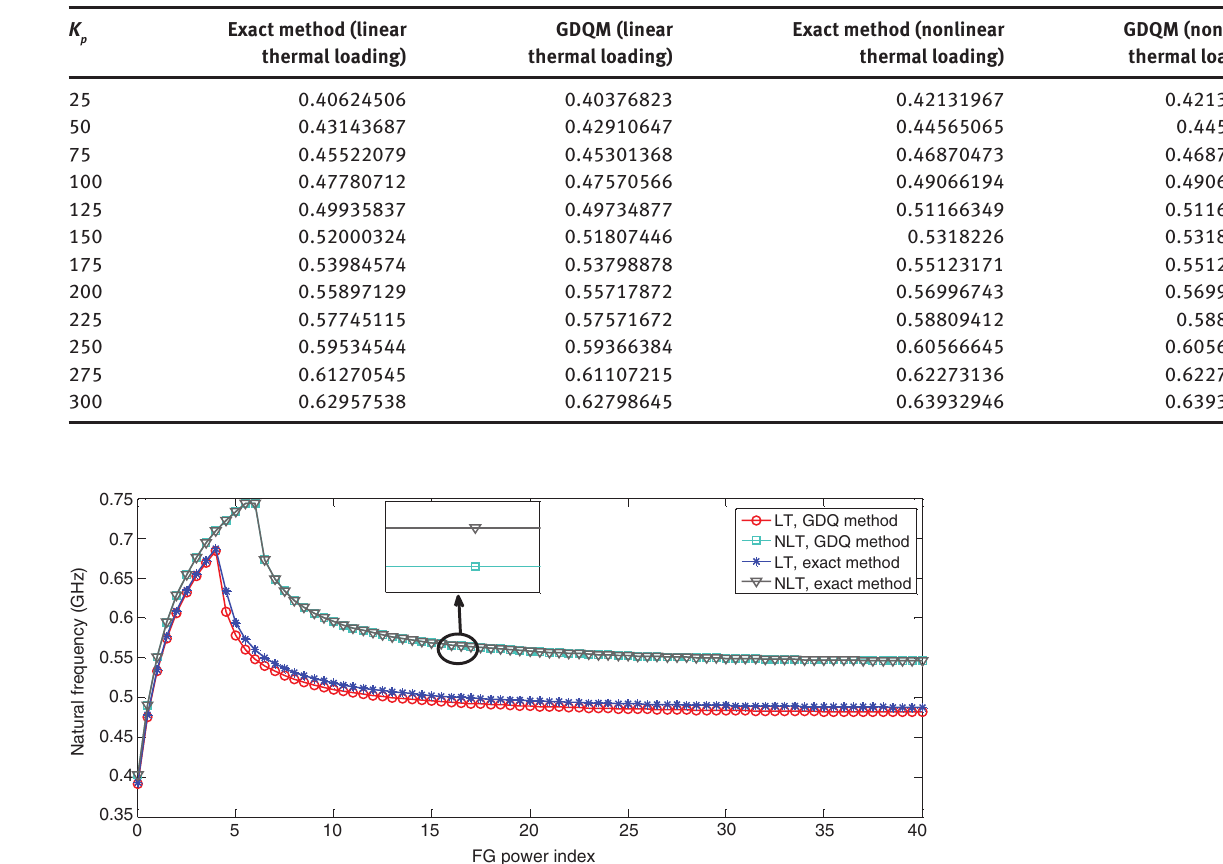
= 10 6 for linear and nonlinear temperature d